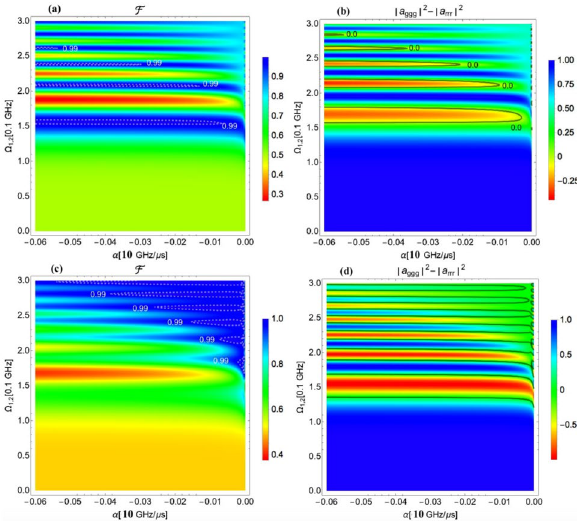
Figure 3. ( a ) The fidelity of the GHZ state as a function of the chirp rate and the peak Rabi frequency for 150 MHz; ( b ) The population difference of states ggg V 31 V / 2 , V max rrr and as a function of the | � = = | � 150 MHz. ( c ) The fidelity of the GHZ state V / 2 , V max chirp rate and the peak Rabi frequency for V 31 = = 120.94 MHz; ( d ) The V / 2 6 , V max as a function of the chirp rate and the peak Rabi frequency for V 31 = = ggg rrr population difference of states and as a function of the chirp rate and the peak Rabi frequency | � | � 120.94 MHz. The parameters used in the calculation are V 60 MHz, τ 0 1 µ s, V / 2 6 , V max for V 31 = = = = (cid:31) 1.5 GHz, and δ 2 / 3 V max . = − = −